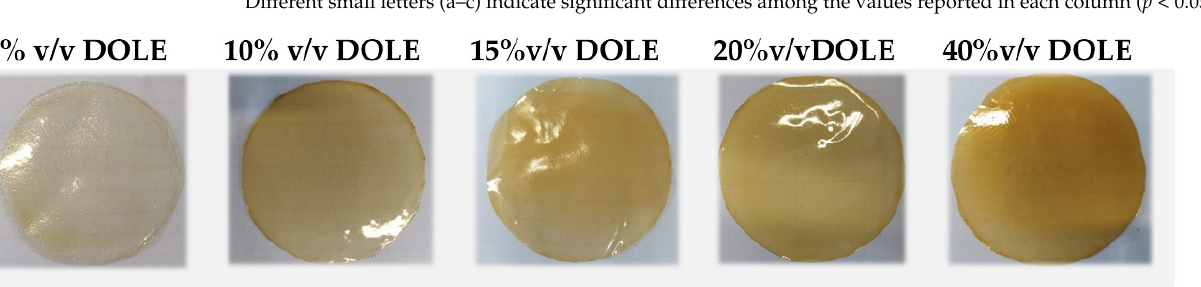
Different small letters (a–c) indicate significant differences among the values reported in each col-